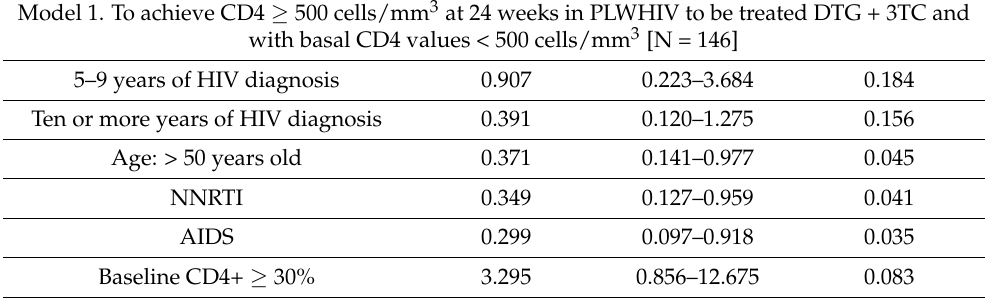
Table 2. The odds ratio of the proposed models associated with nomograms at 24 weeks in PLWHIV to be treated DTG + 3TC. Variable OR IC 95% p -Value Model 1. To achieve CD4 ≥ 500 cells/mm 3 at 24 weeks in PLWHIV to be treated DTG + 3TC